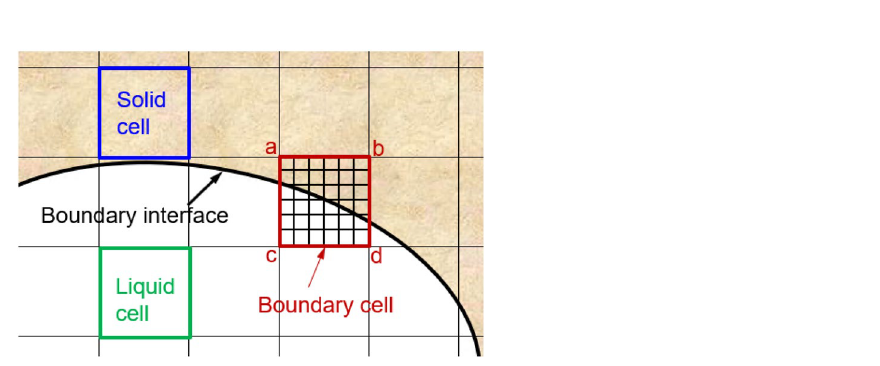
Figure 4. Signed distance field φ( x ) > 0 mean inside and outside of surface Γ. and φ( (cid:31)